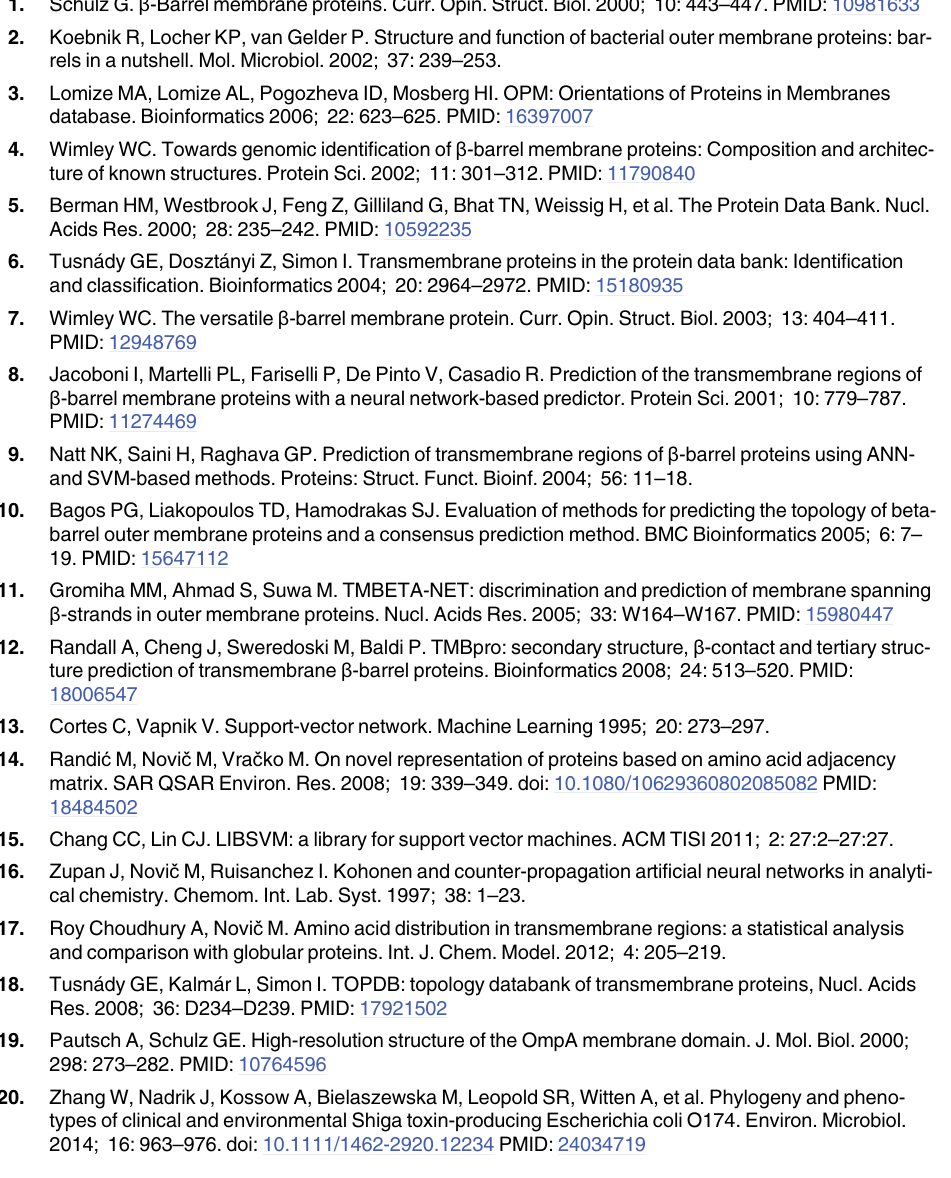
S1 Table. Benchmark dataset of 35 β TM proteins. S2 Table. Transmembrane region prediction results for the 35 β TM proteins from the benchmark dataset using the Pred β TM